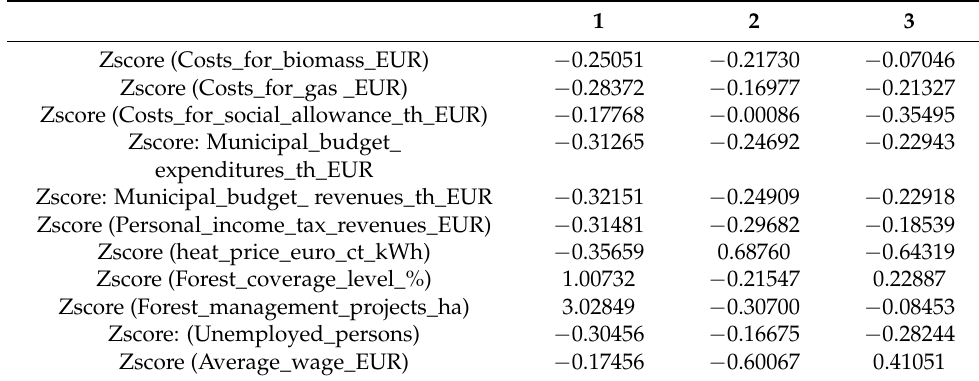
Table 5. The results of final cluster centers